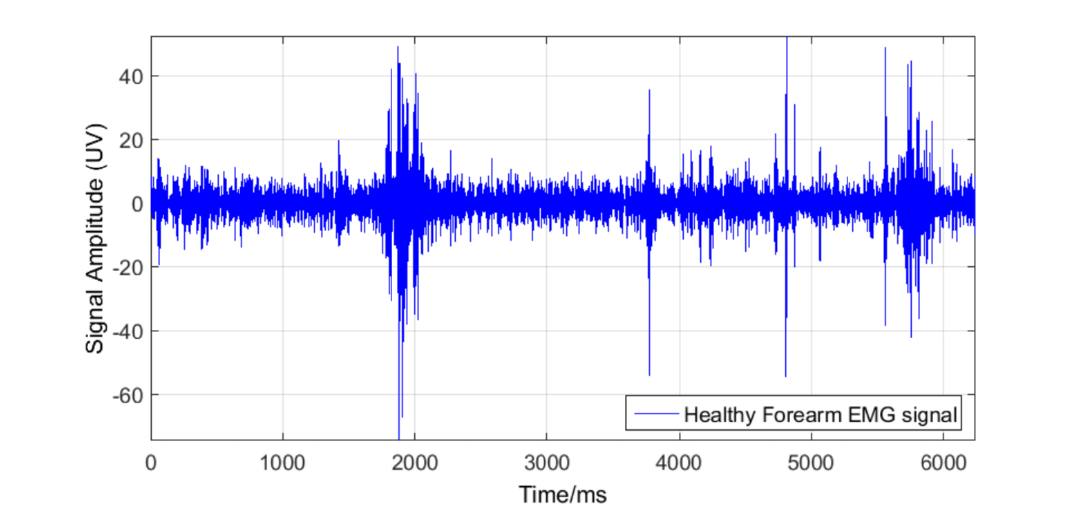
Figure 5. EMG (forearm) signal of a healthy